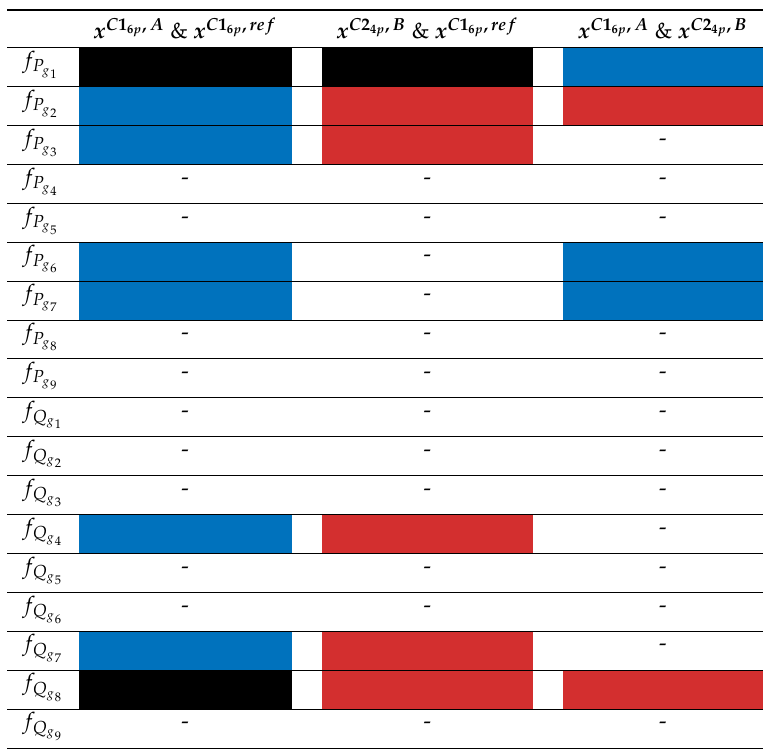
Table 9. Comparison, in pairs, of the parameter sets x C 1 6 p , ref , x C 1 6 p , A , and x C 2 4 p , B for each performance index. Black, blue, and red cells highlight those indices for which the solutions x C 1 6 p , ref , x C 1 6 p , A , and x C 2 4 p , B are significantly better,